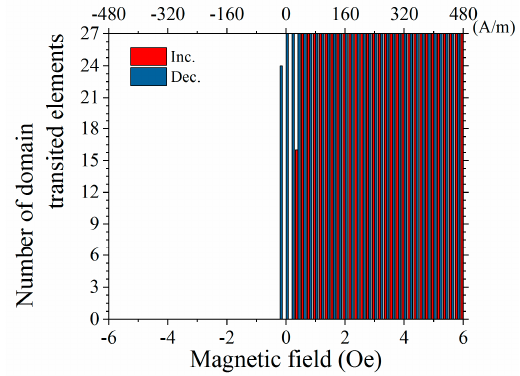
Figure 11. Number of domain transitions as a function of the applied magnetic field for individual elements.